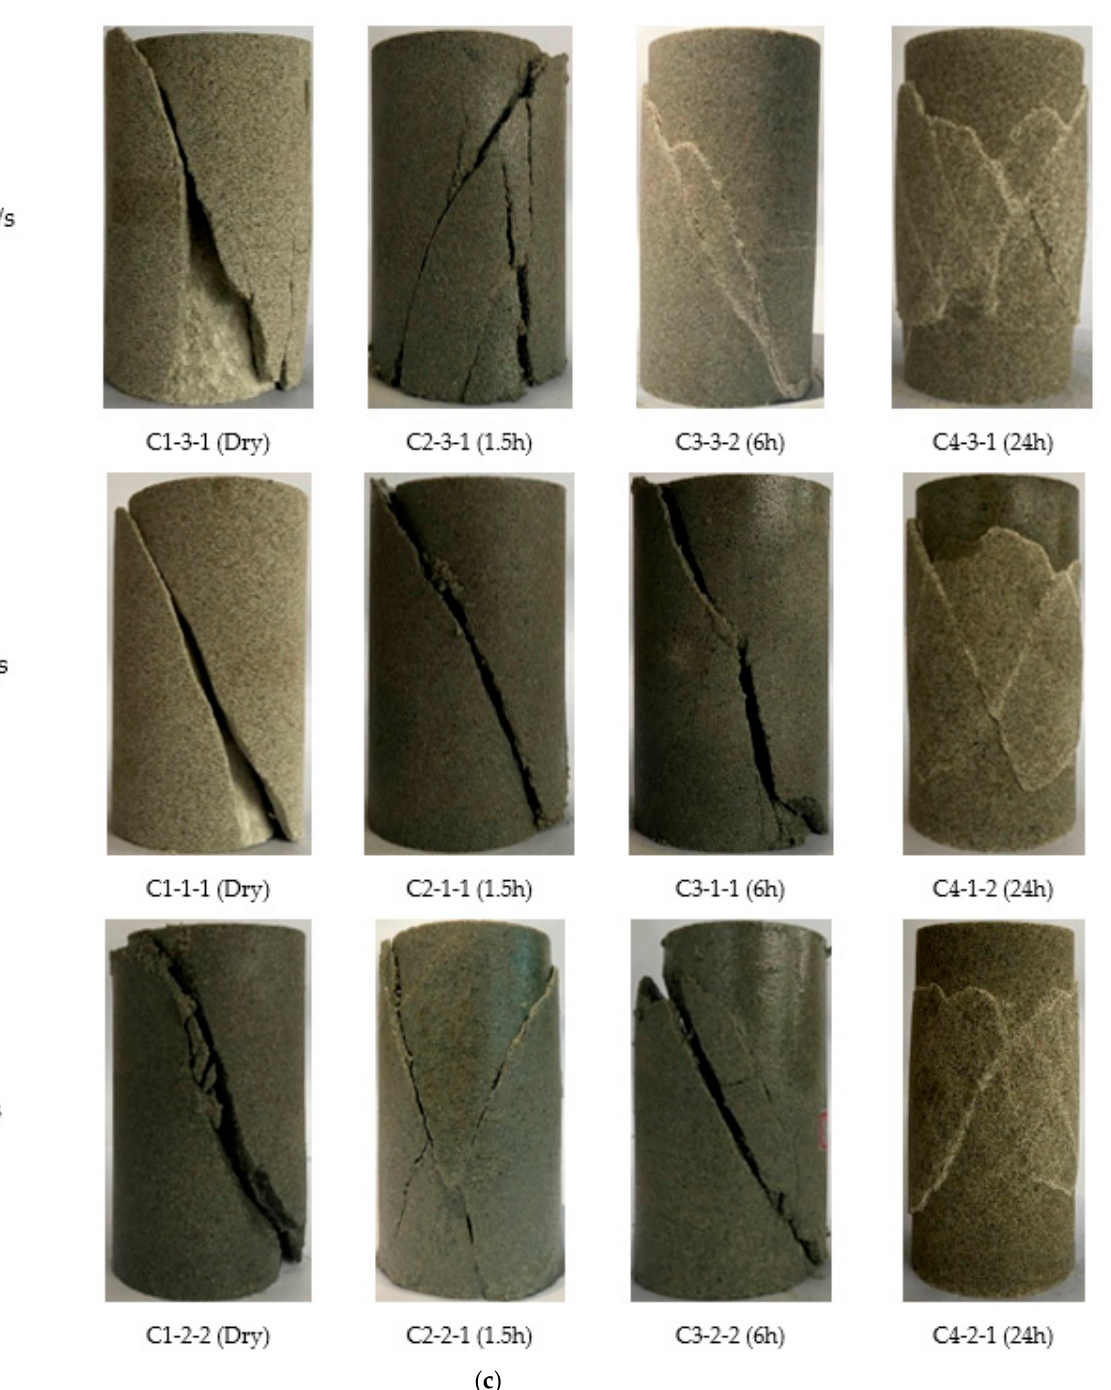
Figure 10. Relationship between mechanical parameters and water content. ( a ) The uniaxial com- pression test. ( b ) The conventional triaxial compression test. ( c ) A test of constant axial pressure and unloading confining